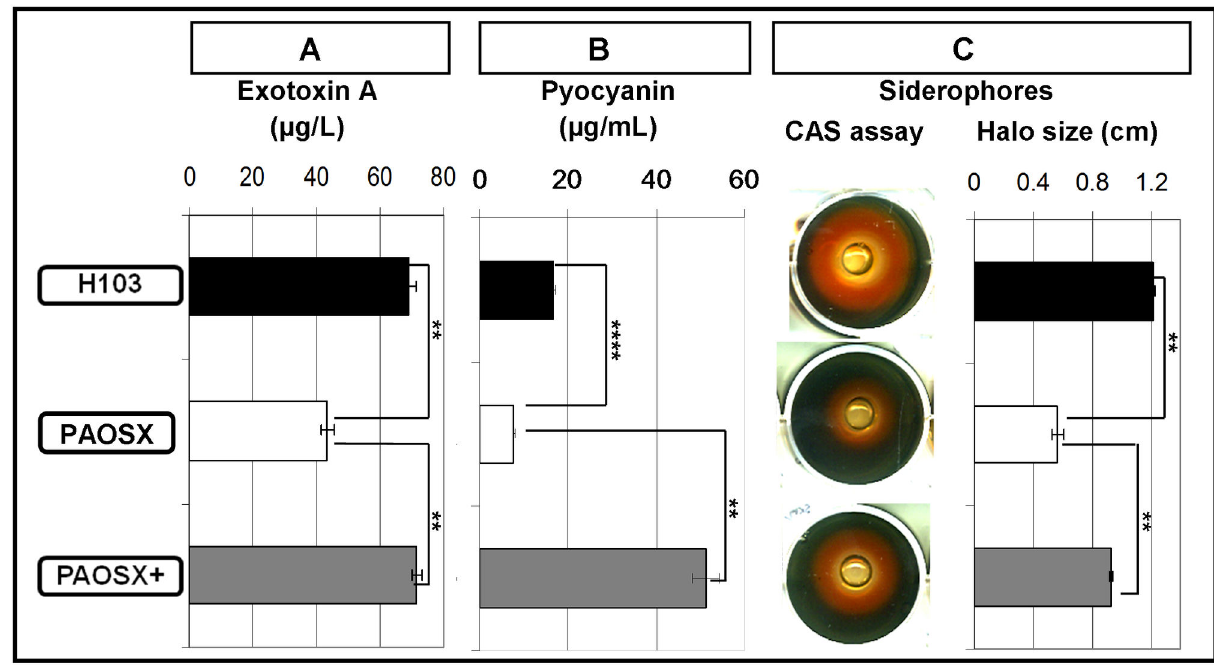
Figure 3. Altered levels of (A) exotoxinA, (B) pyocyanin and (C) siderophores in the culture supernatants of the sigX mutant. H103 (black), PAOSX (white) and PAOSX+ (grey) culture supernatants were obtained from overnight cultures in (A) LB, (B) King A or (C) King B media. The relative amounts of exotoxin A, pyocyanin and the total siderophores were assayed at least three times independently for each strain and means and standard deviations are presented. For the Chrome Azurol S (CAS) assay, the haloes around the wells in the CAS plate show siderophore production in sample supernatant. Statistics were done by pairwise strain comparisons ( t test). * p -value<0.05, ** p -value<0.01, *** p -value<0.001, **** p -value<0.0001, NS no significant difference. doi: